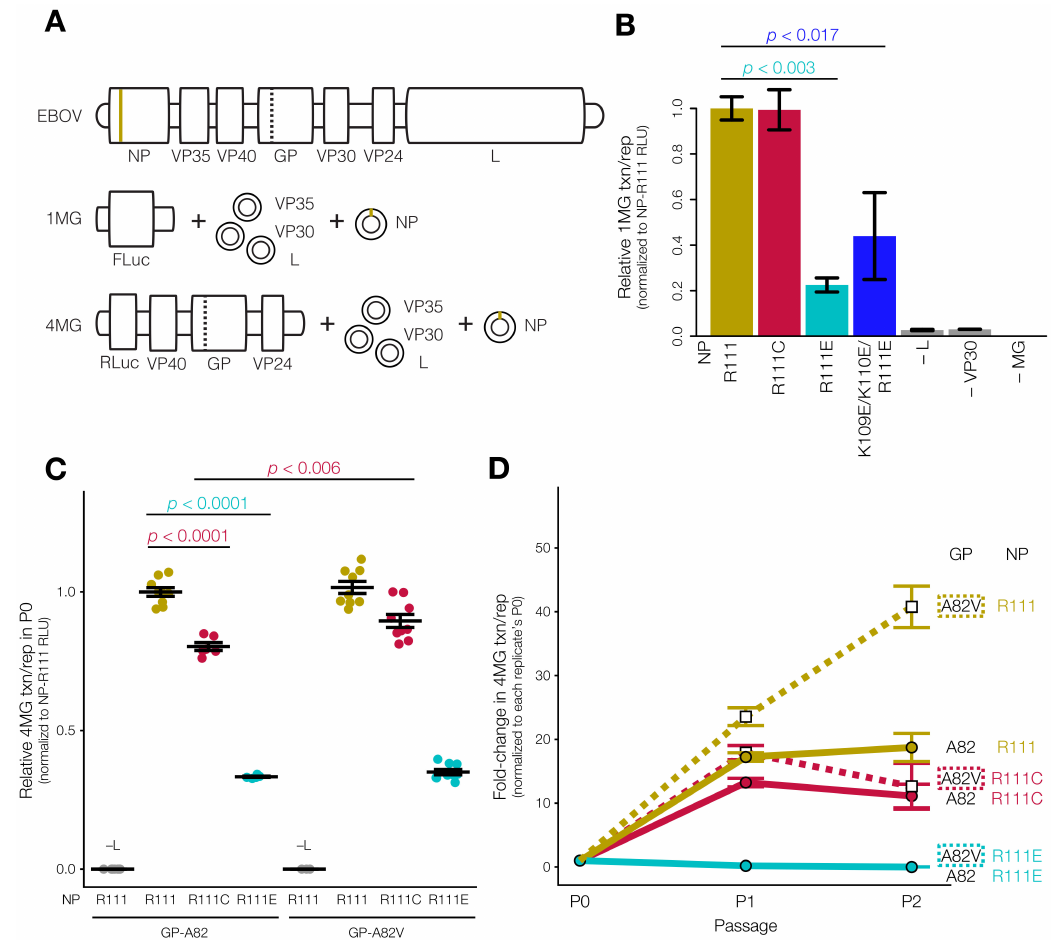
Figure 5. EBOV NP position 111 influences viral transcription and replication. ( A ) Schematic of monocistronic minigenome (1MG) and tetracistronic minigenome (4MG) systems. Compared to live virus genome (top), 1MG only encodes the EBOV leader and trailer sequences (middle), whereas the 4MG encodes the structural proteins VP40, GP, and VP24 (bottom). In both cases, the replication complex proteins (NP, VP35, VP30, and L) are expressed from plasmids in trans. Tan line indicates the position of NP-R111, and the dashed line indicates the position of GP-A82 (encoded on 4MG but not 1MG); ( B ) 1MG assay. We expressed NP mutants or ancestral NP-R111 in HEK 293T cells in the presence of the EBOV replication complex (L, VP35, VP30), and measured transcription and replication (txn / rep) of the 1MG minigenome encoding firefly luciferase (FLuc) relative to a Renilla luciferase (RLuc) loading control ( n = 3 biological replicates). We normalized values to NP-R111. Absence of L, VP30, or 1MG abolished FLuc signal. Both NP-R111E and NP-K109E / K110E / R111E charge-reversal mutants significantly decreased 1MG activity (ANOVA-Dunnett’s test). Error bars indicate mean ± SEM; ( C ) P0 producer cells of 4MG assay. We expressed transcription- and replication-competent (tr)VLPs harboring GP-A82 (left) or GP-A82V (right) and NP mutants in HEK 293T cells, and measured 4MG minigenome activity (RLuc) relative to an FLuc loading control ( n = 3–9 biological replicates). We normalized values to GP-A82 / NP-R111 and assessed statistical significance by ANOVA with Tukey’s test (ANOVA-Tukey’s test) to correct for multiple hypothesis testing. Error bars indicate mean ± SEM; ( D ) Target P1 and P2 cells of 4MG assay. We expressed the EBOV replication complex in P1 Huh7 cells, and then infected P1 cells with P0 trVLPs, and measured 4MG activity. We repeated the process by expressing the EBOV replication complex in P2 Huh7 cells, infecting P2 cells with P1 trVLPs, and measuring 4MG activity again ( n = 3–9 biological replicates). We normalized values for cells in each biological replicate to its own P0 activity and assessed statistical significance by ANOVA-Tukey’s test. Solid lines and filled circles indicate GP-A82, whereas dashed lines and open squares indicate GP-A82V. Error bars indicate mean ±